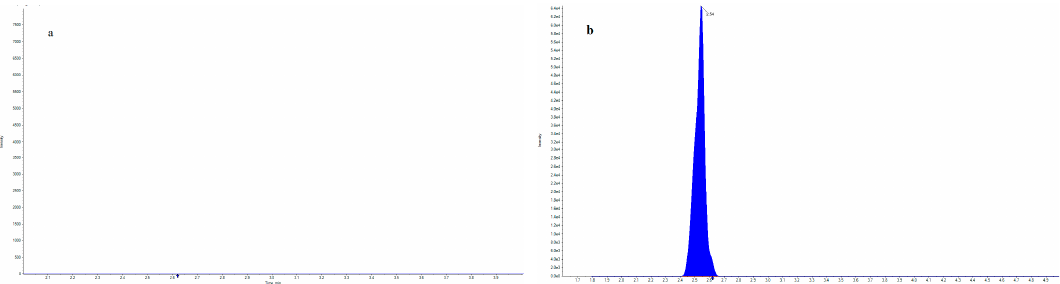
Figure 1. Example chromatograms of ( a ) blank liver sample and ( b ) liver containing strychnine residues at a concentration of 150 µ g /